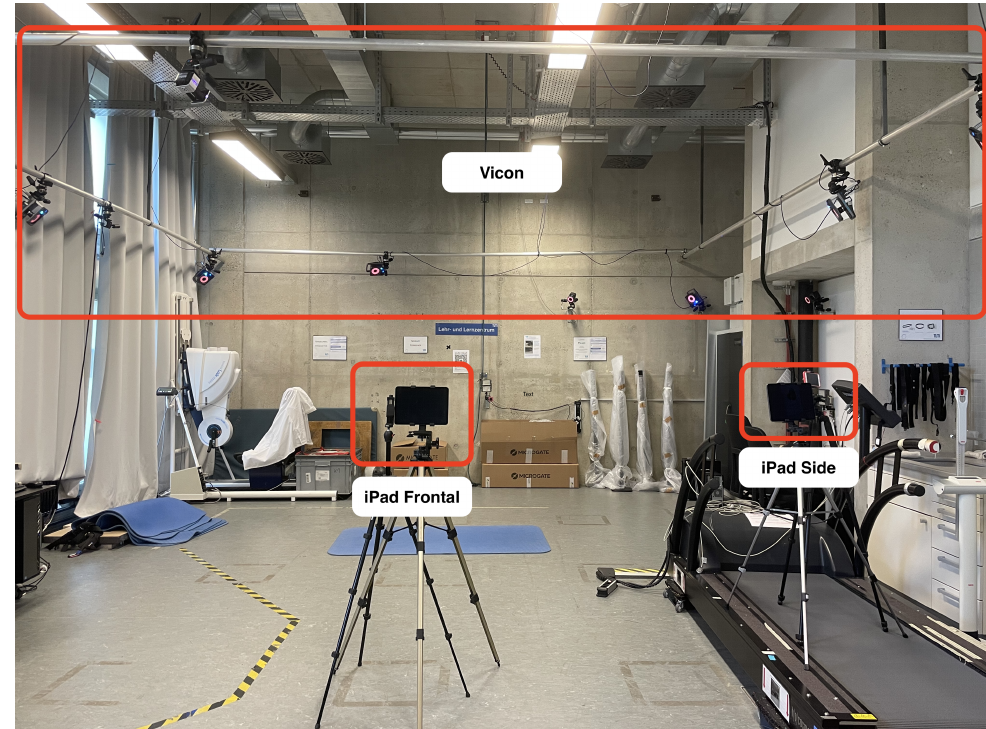
Figure 2. The experiment setup, showing the positioning of the recording devices and the